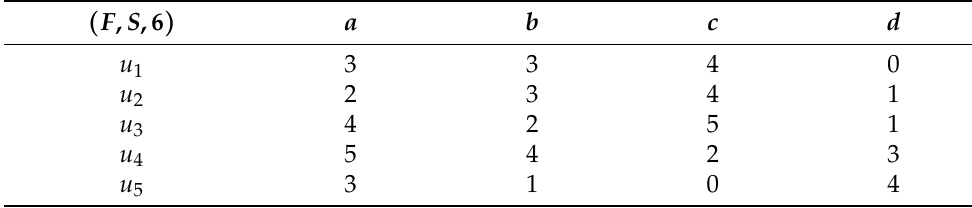
Table 10. The 6-Soft Set of ( F , S ,6 ) .